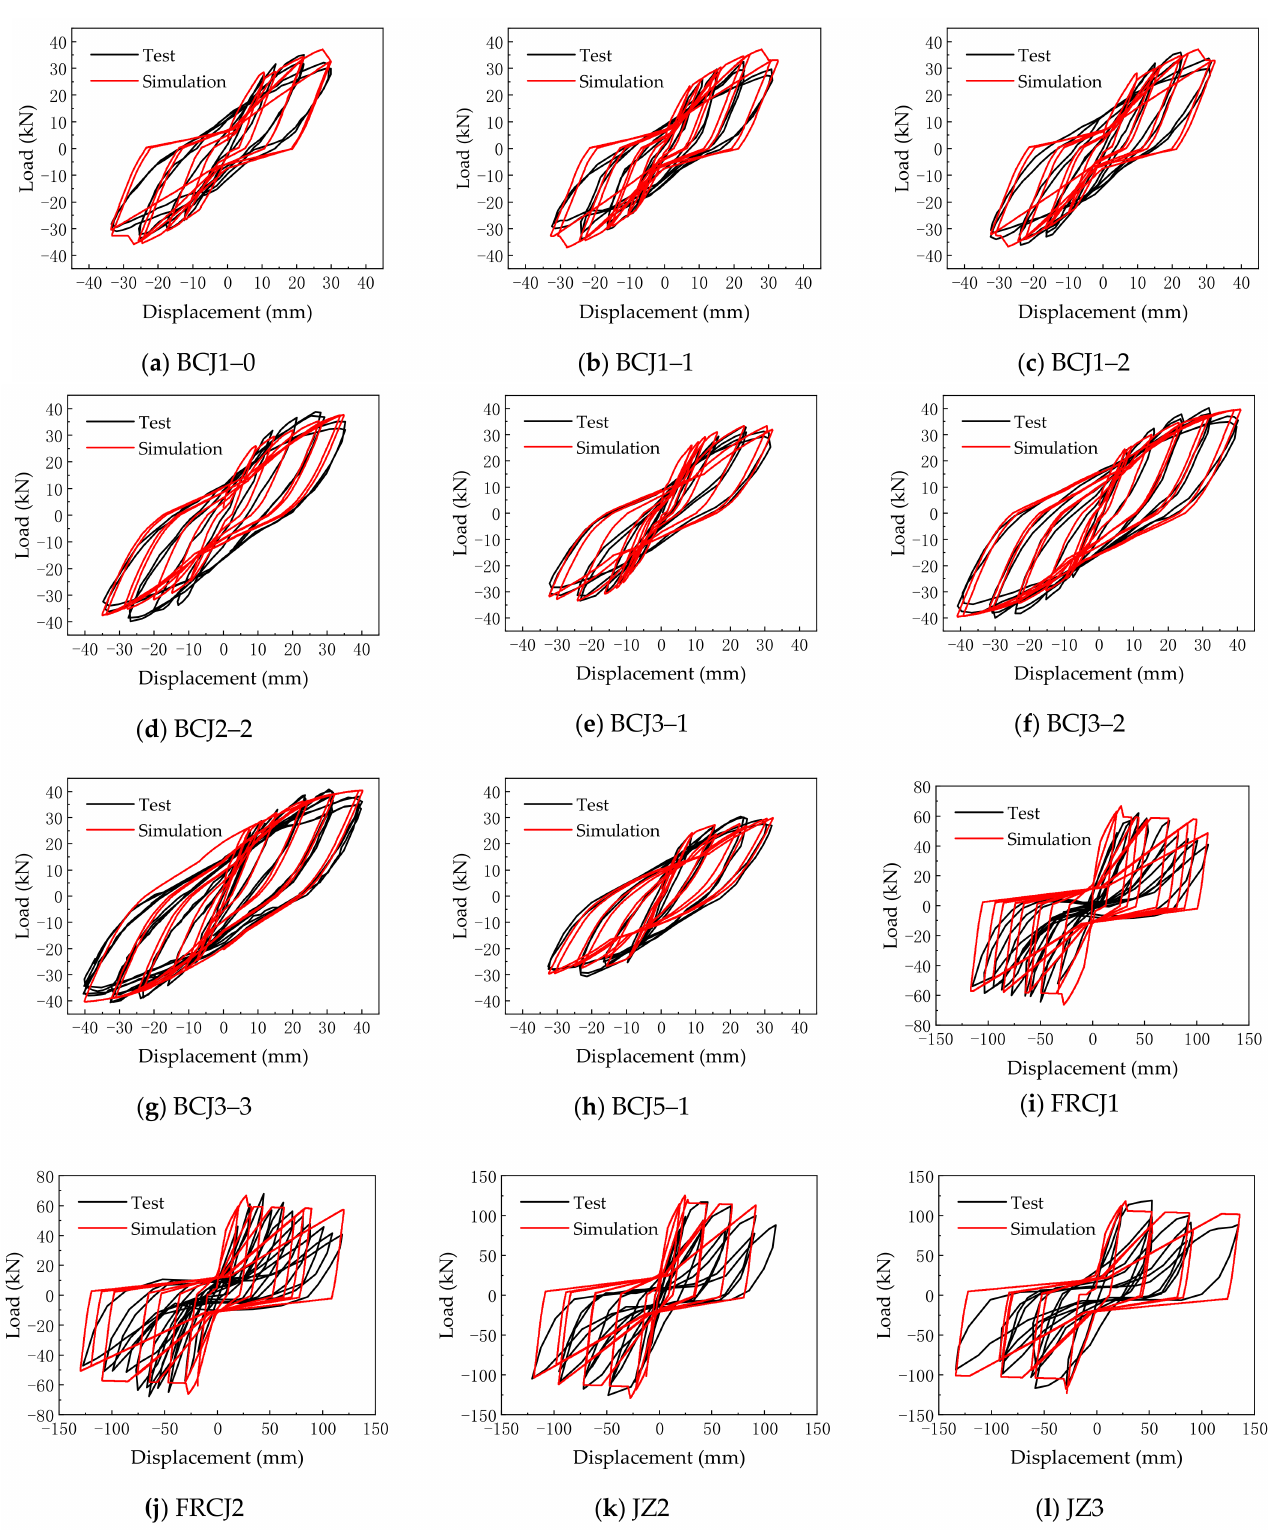
Figure 12. Hysteretic